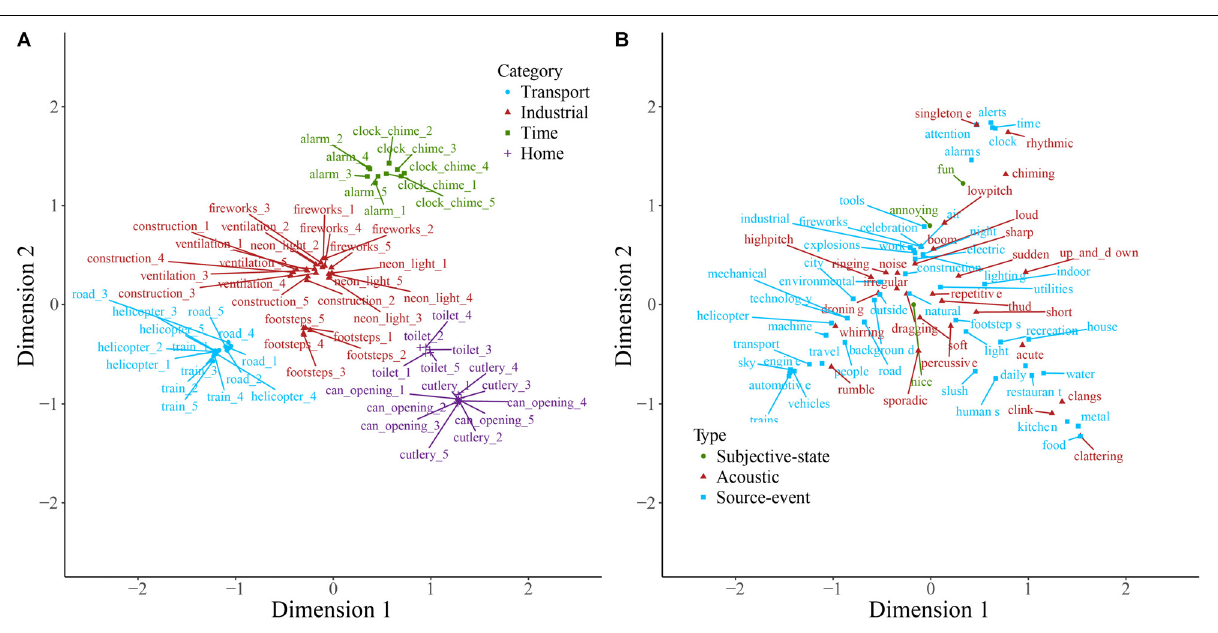
FIGURE 3 | Manmade sounds (A) and descriptive words (B) plotted on the first two dimensions of categorization data. Note that the dimensions are the same in both panels. Sounds (A) are colored according to which of the main categories they belong to, and descriptive words (B) are colored according to type. Labels are displaced from their corresponding data point, indicated by a connecting line, to avoid